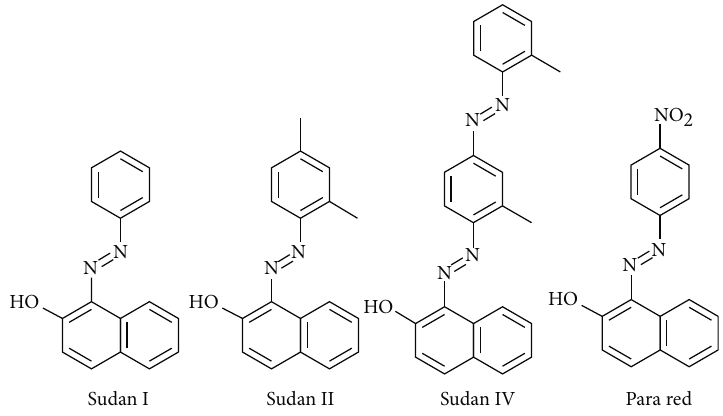
Figure 5: Structure formulae of some common names of azo dyes under study